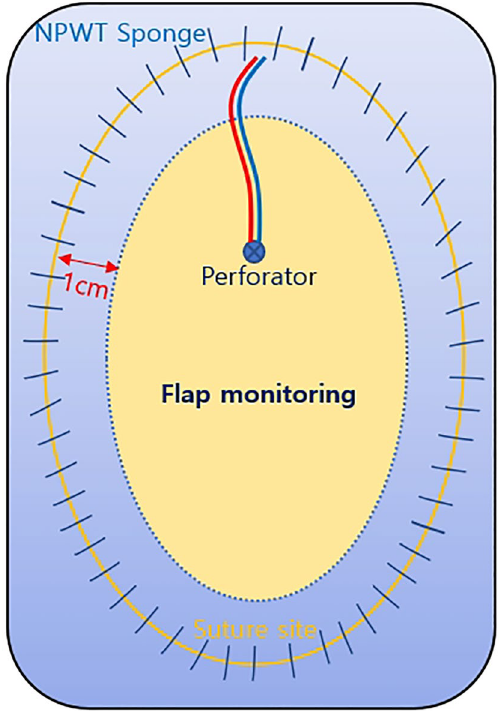
Figure 1. Schematic diagram of the novel NPWT system for postoperative flap